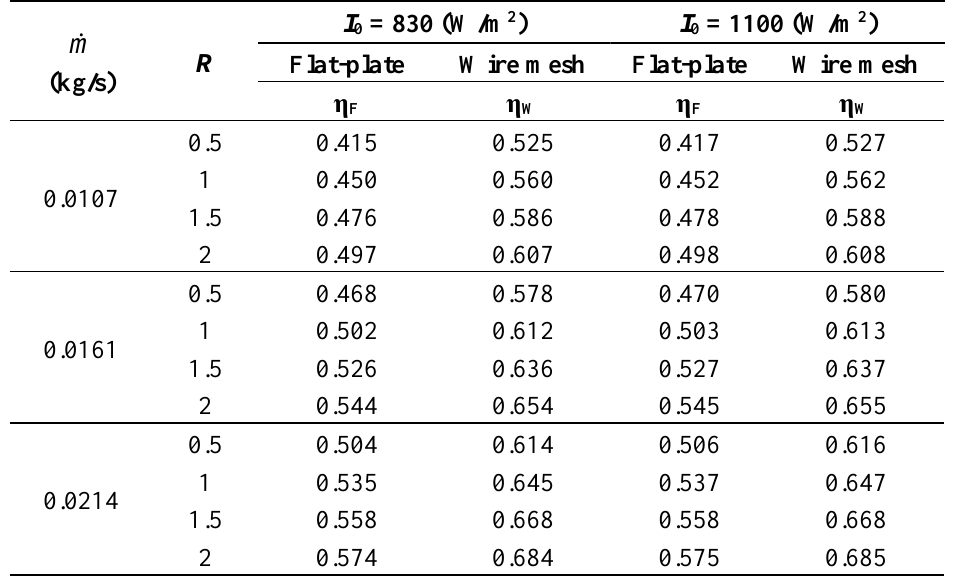
Table 2. Theoretical predictions of heat transfer efficiency of η F and η W .